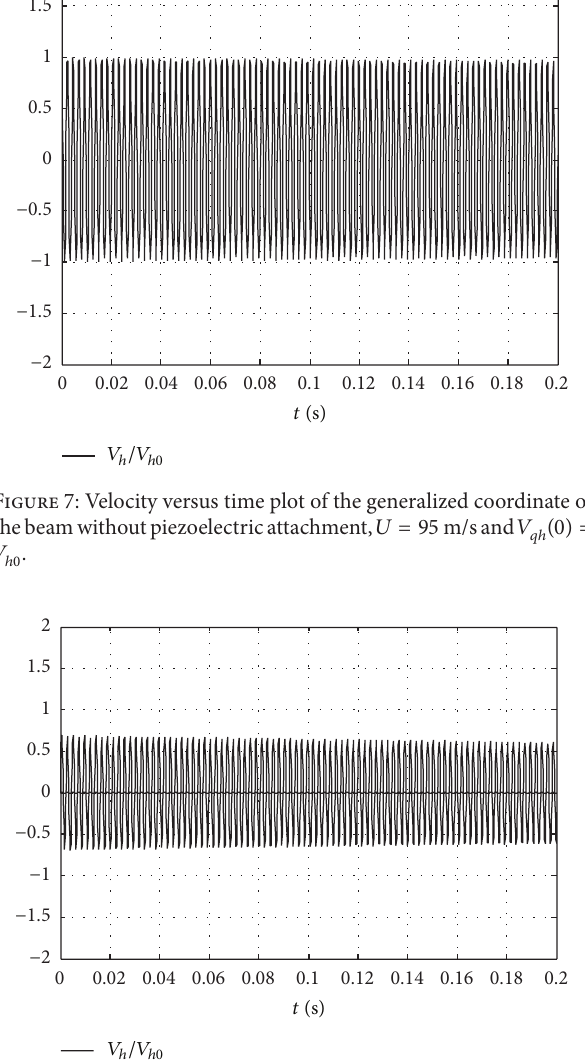
Figure 6: Displacement versus time plot of the generalized coordi- nate of the beam with piezoelectric attachment, 𝑅 = 0.01 , 𝜇 𝑥ℎ1 = 1 , = 0.3 , 𝑈 = 95 m/s, 𝑞 𝜇 V ℎ1